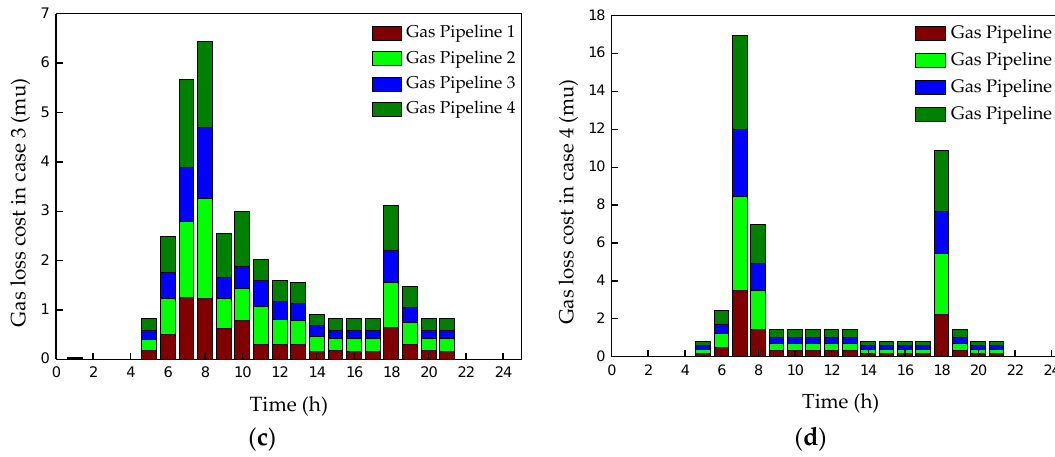
Figure 13. Gas loss cost in the gas network for different cases: ( a ) Case 1; ( b ) Case 2; ( c ) Case 3; ( d ) Case 4.